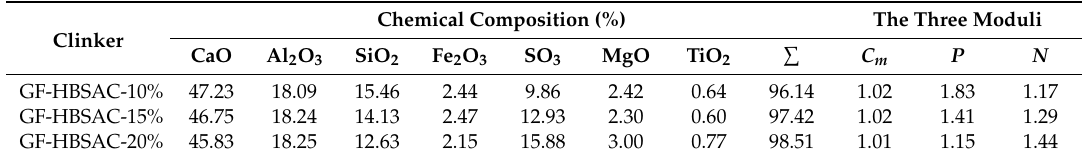
Table 5. Chemical composition and the three moduli of the Series GF-HBSAC-Y cement clinkers. Chemical Composition Clinker